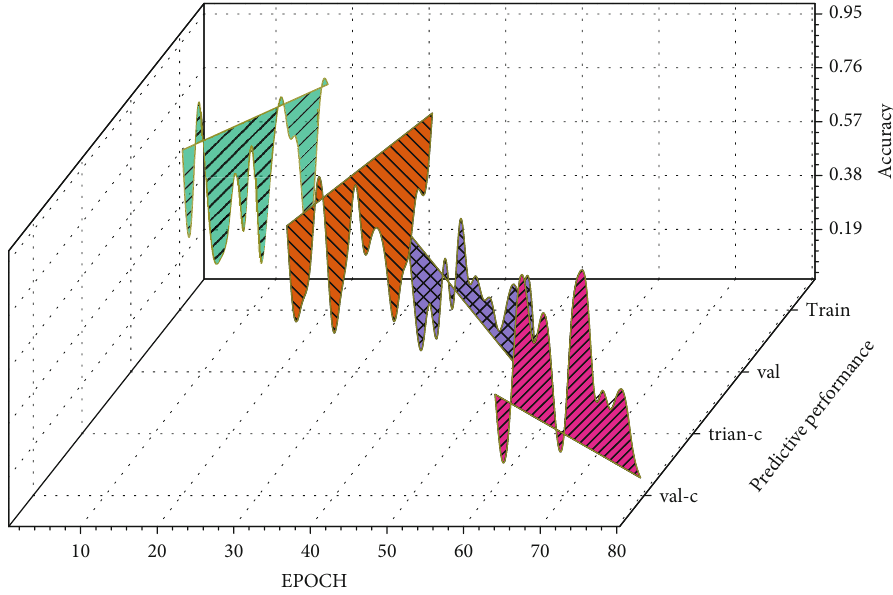
Figure 7: Training model accuracy.